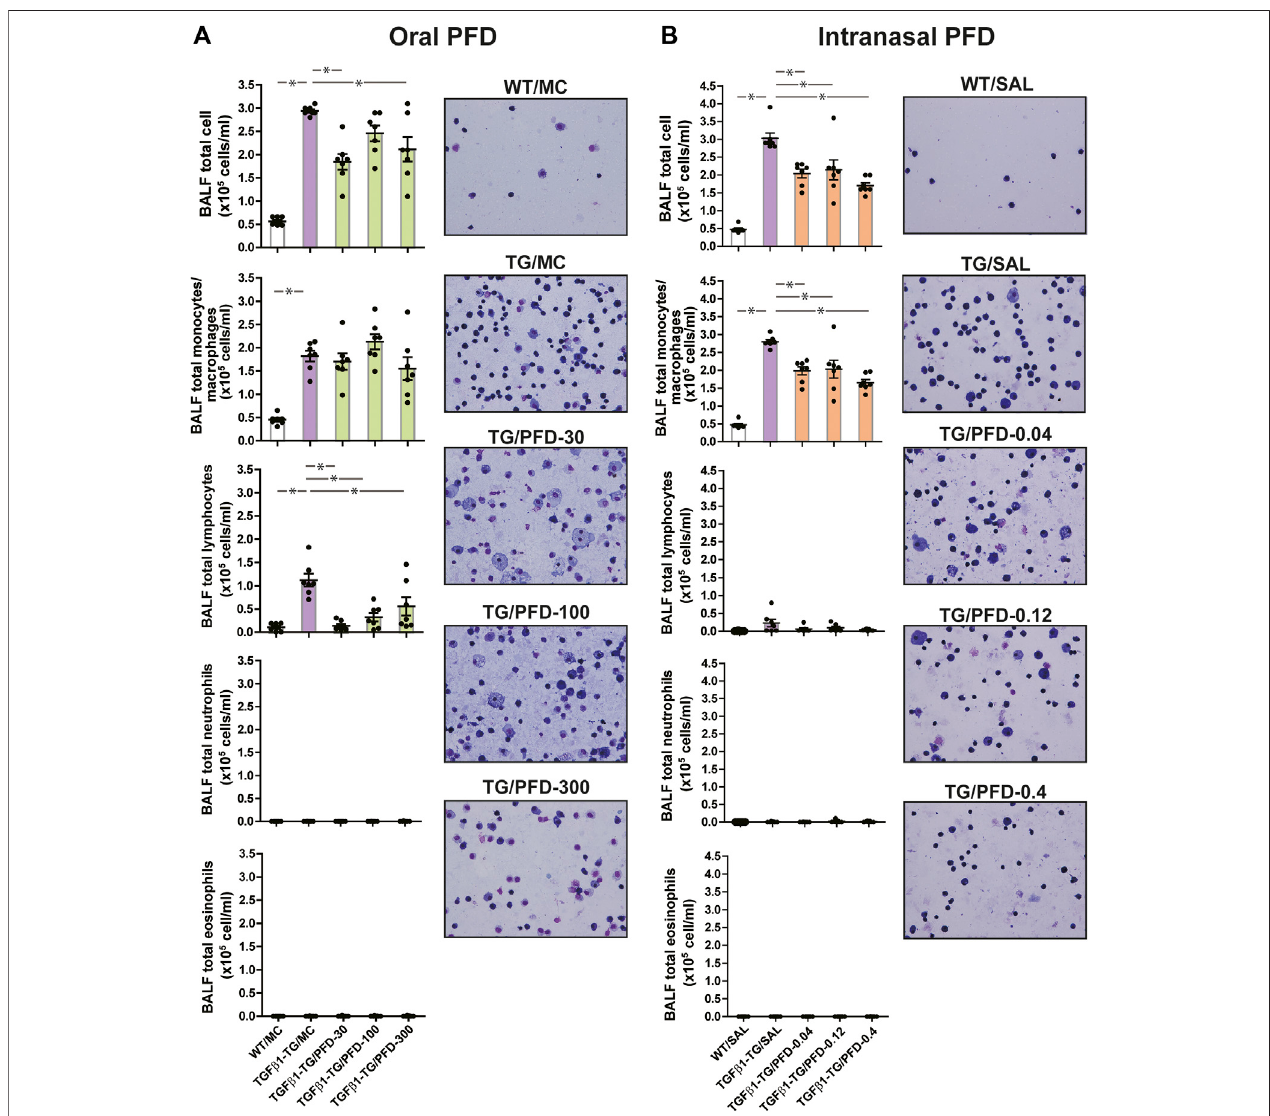
FIGURE 2 | Signi fi cant reduction in the number of in fl ammatory cells in the lungs from mice treated with pirfenidone (PFD) by oral or intranasal administration comparedtocontrols.Humantransforminggrowthfactor(TGF) β 1transgenic(TG)micewereallocatedingroupstreatedwithPFDbyoral( A ; n (cid:2) 7)orintranasal( B ; n (cid:2) 7) administration and in groups treated with the vehicle saline (SAL; n (cid:2) 7) or with the vehicle methylcellulose (MC; n (cid:2) 7) twice a day for 21 days and once a day on day 22 beforeeuthanasia.Wildtype(WT; n (cid:2) 7)micetreatedwithSALorMCwereusedasnegativecontrols.Bronchoalveolarlavage fl uid(BALF)cellswerecountedusing a nucleocounter and stained with Wright-Giemsa as described under materials and methods. Scale bars indicate 50 µm. Data are expressed as the mean ± S.E.M. Statistical analysis by Student ’ s t -test and ANOVA with Dunnett ’ s post hoc test. * p < 0.05.